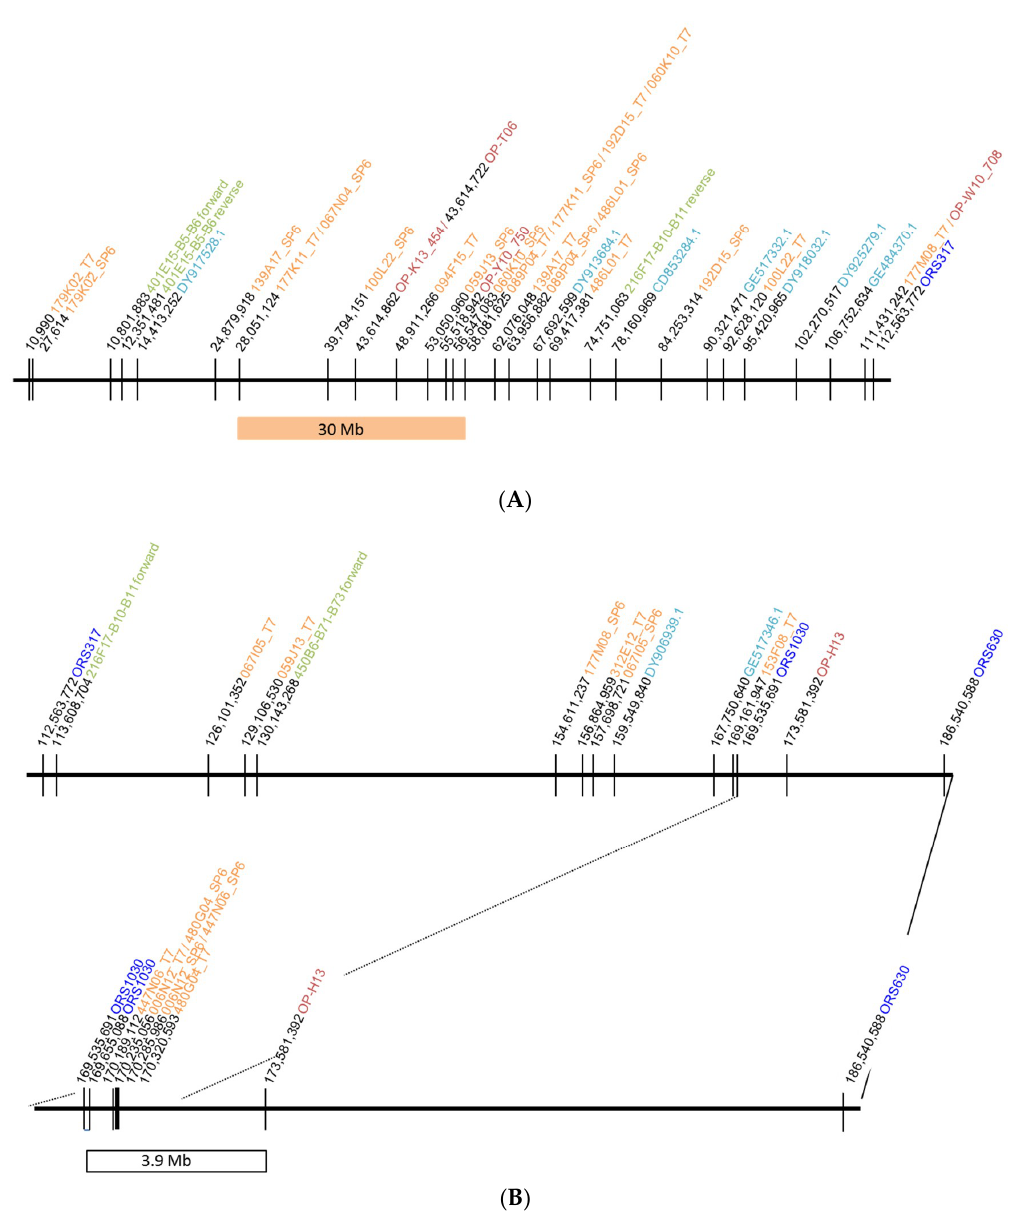
Figure 1. BLAST results of BAC clones and marker sequences against chromosome 13 of the HanXRQ genome sequence. ( A ) region between 10,990 and 112,563,772; ( B ) region between 112,563,772 and 186,540,588. BAC clones (T7 or SP6 sequences) are shown in orange, RAPD markers in red [14], SSR markers in blue [44], and SNP markers in turquoise [43]. The two areas investigated for potential candidate genes for Rf1 are shown as orange bar and white bar.